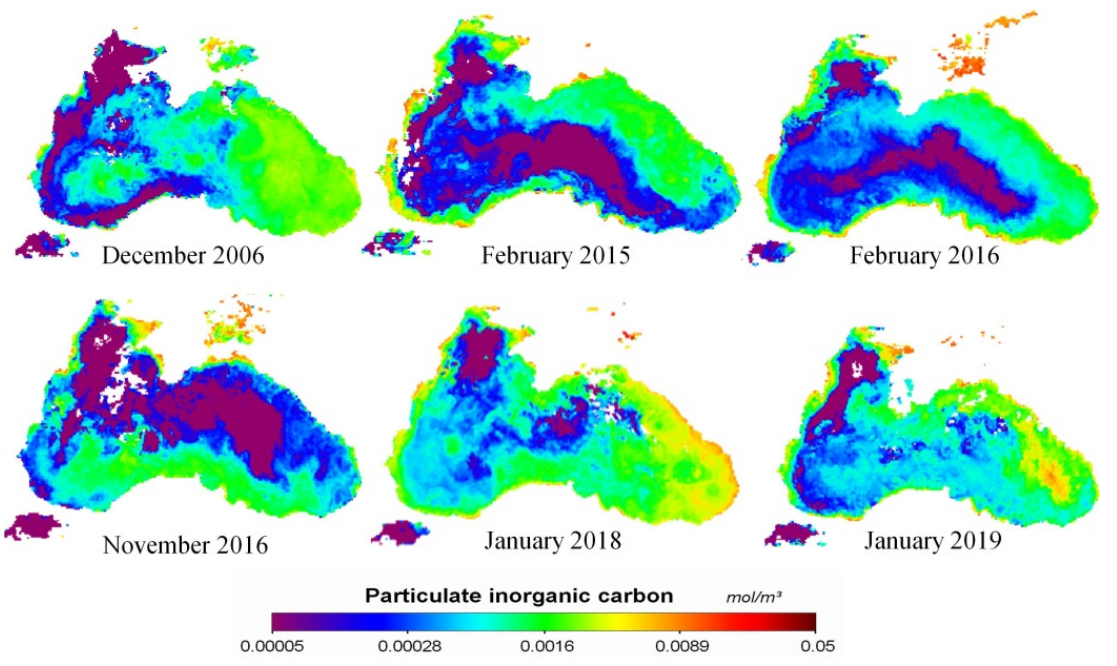
Figure 17. Winter blooms of coccolithophores (PIC) according to the